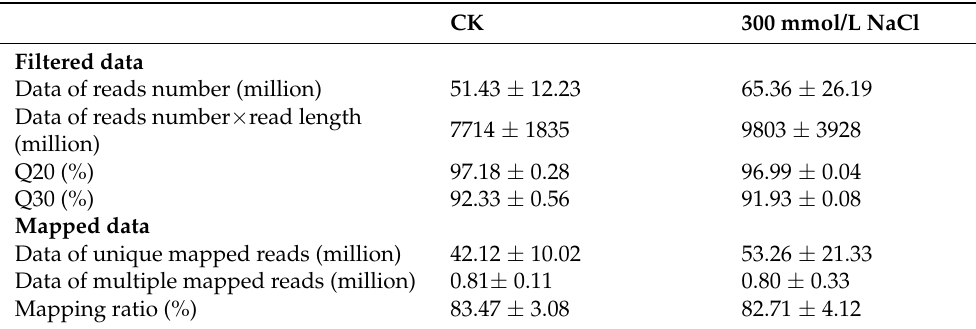
Table 1. Summary of sequencing data of seed germination under the CK and 300 mmol/L treatments (mean ± SD, n =